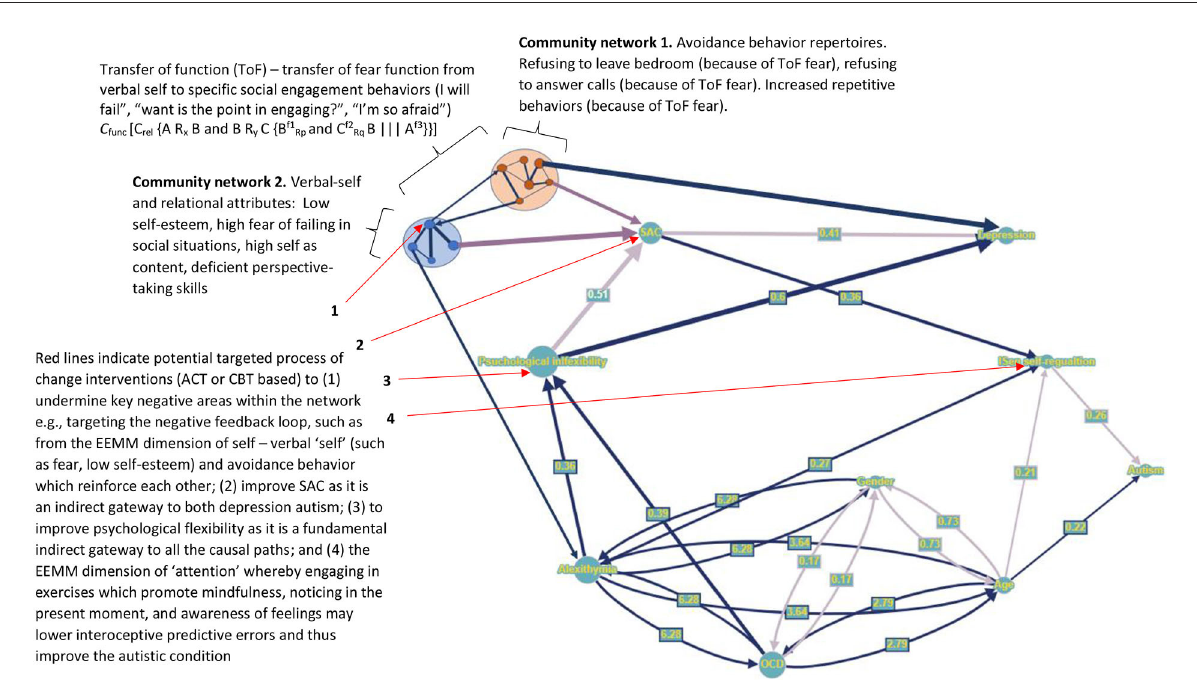
FIGURE5 A conceptual extension of the graph nodes and edges representation in Figure 4, when extending ideographically and implemented through a more dynamic RFT PBT approach which include additional community cluster